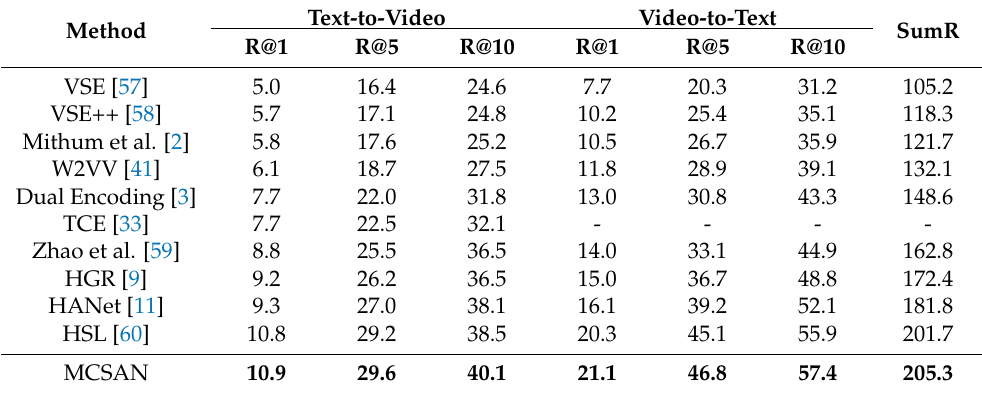
Table 1. Comparisons with the state-of-the-art video–text retrieval methods on the MSR-VTT dataset. The best performance are marked in bold. Our proposed model performs the best.